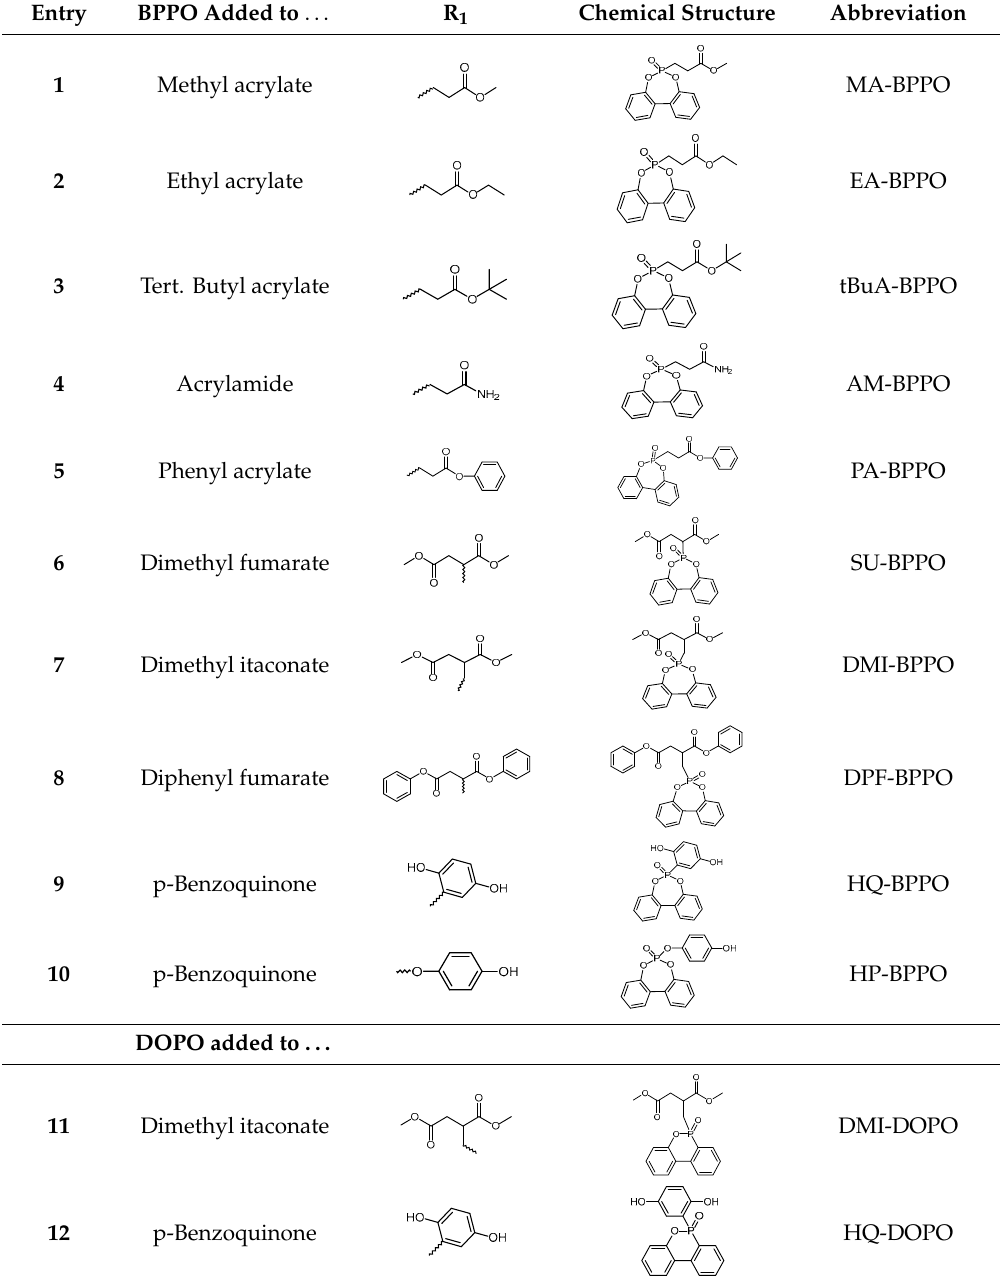
Table 1. BPPO derivatives studied as flame retardant (FR) additives in polyurethane foams.